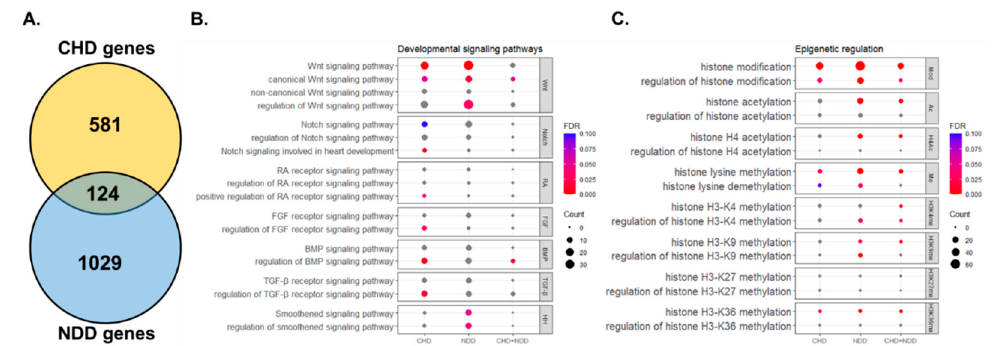
Figure 1. Gene Ontology (GO) analysis of shared genetics in both CHD and NDD. ( A ). Venn diagram representing overlap between high-risk genes in CHD [6] and NDD [5] used for GO analysis (GO biological process). ( B ). Dot plot graph (number of input genes in each GO term) and significance (false discovery rate, FDR) in GO terms related with developmental signaling pathways. ( C ). Similar to B, but with GO terms related with epigenetic regulation.